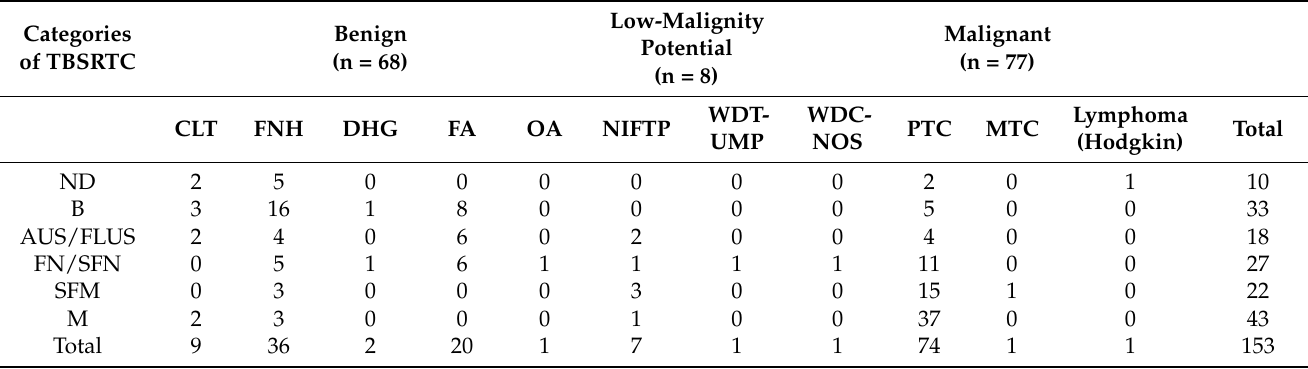
Table 5. Distribution of SPFU cases based on the histological types and TBSRTC